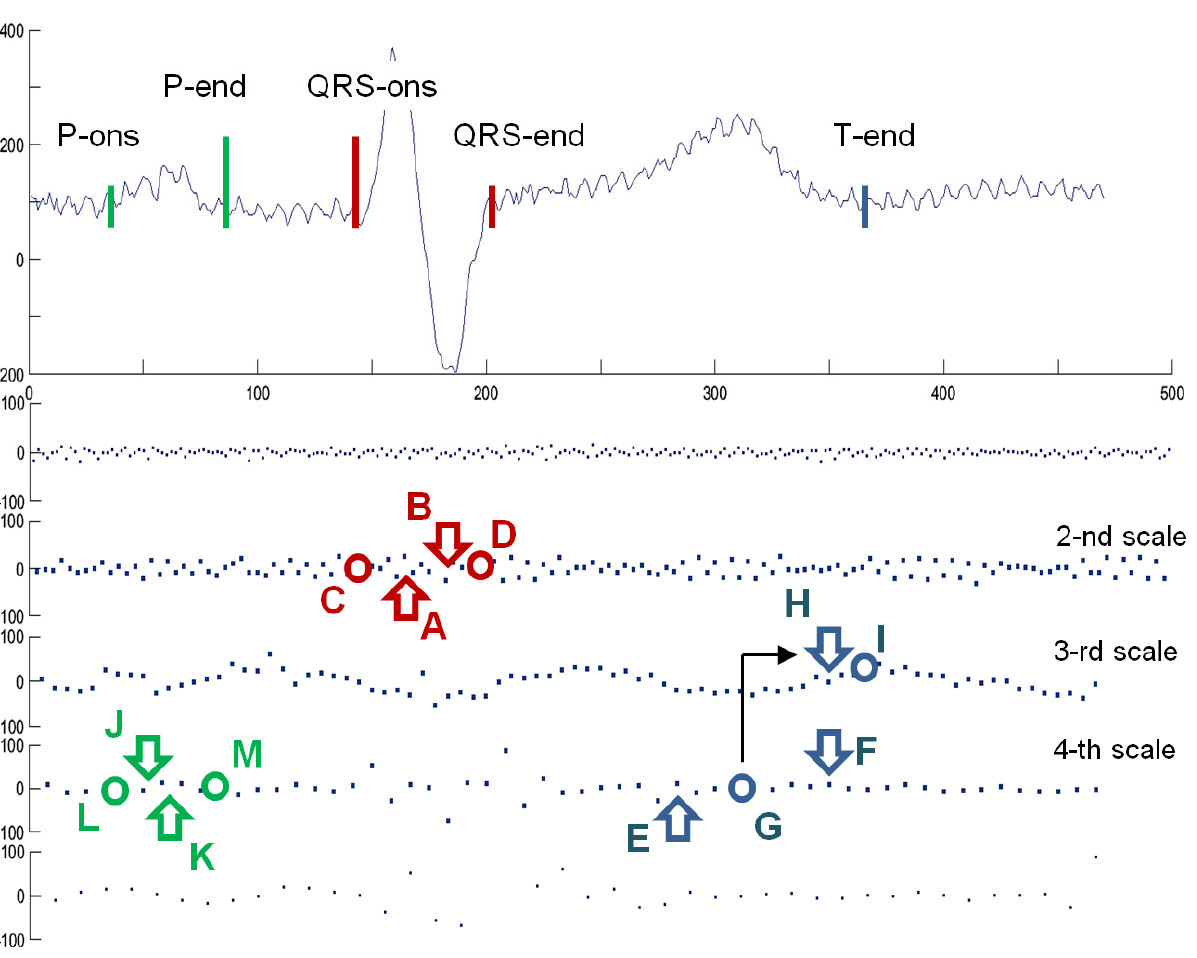
Figure 6. Wave search and delimitation rules in time-scale ECG representation (based on [81], the example is taken from CSE Multilead Database MO_001 lead I). Search points for QRS delimitation points are marked in red, related to T-wave end in blue and related to P-wave borders–in green. Letters A-M refer to explanation of the procedure in the section above.